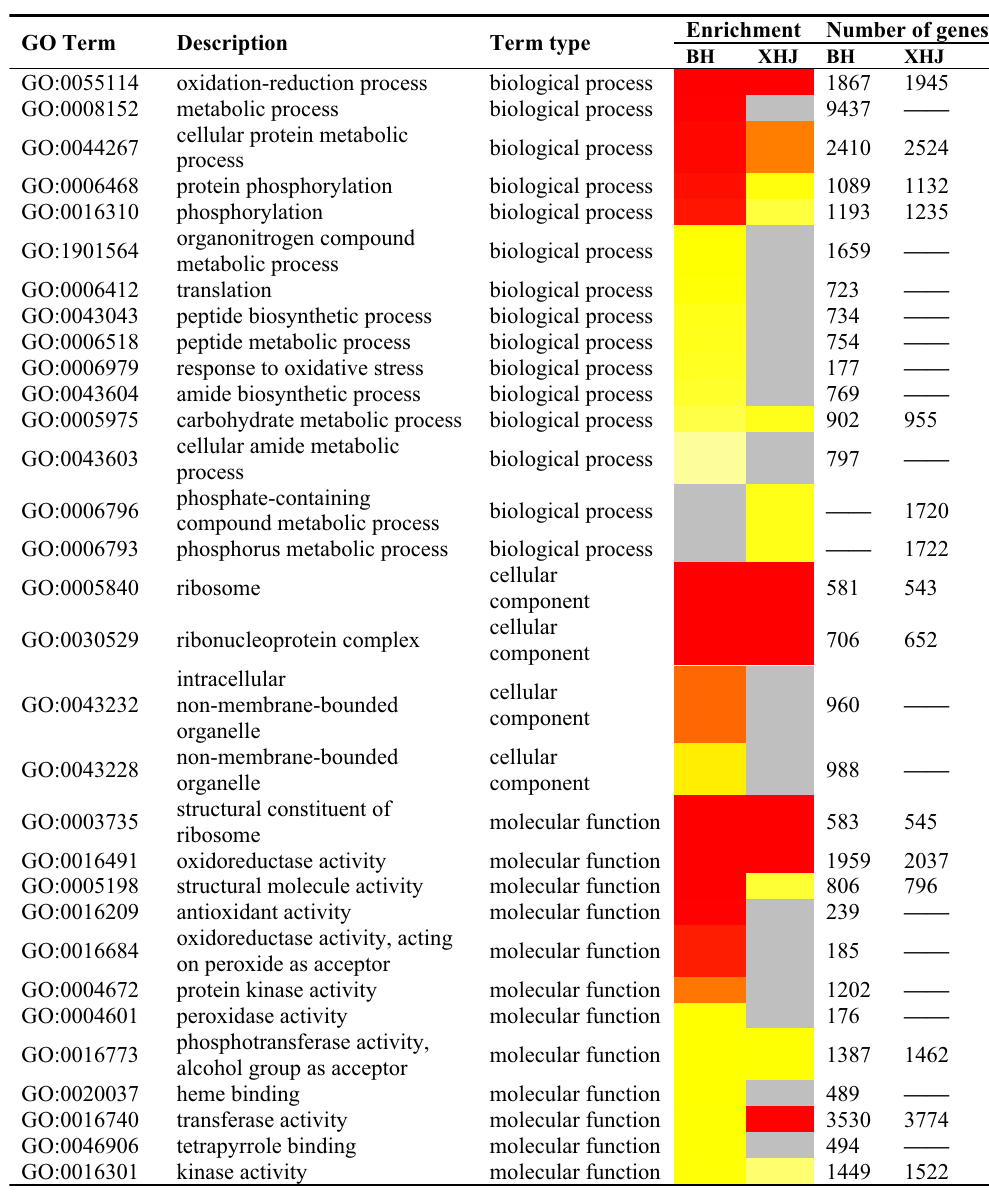
Table 2. Comparison of Gene Ontology (GO) term enrichment analysis of DEGs in BH group and XHJ group. Significance levels are based on enrichment and lowest P values with a cutoff of < 10 −10 . Different color means different degree of enrichment, higher significant terms indicated by red, lower significant terms indicated by yellow, gray means no term assigned in that particular